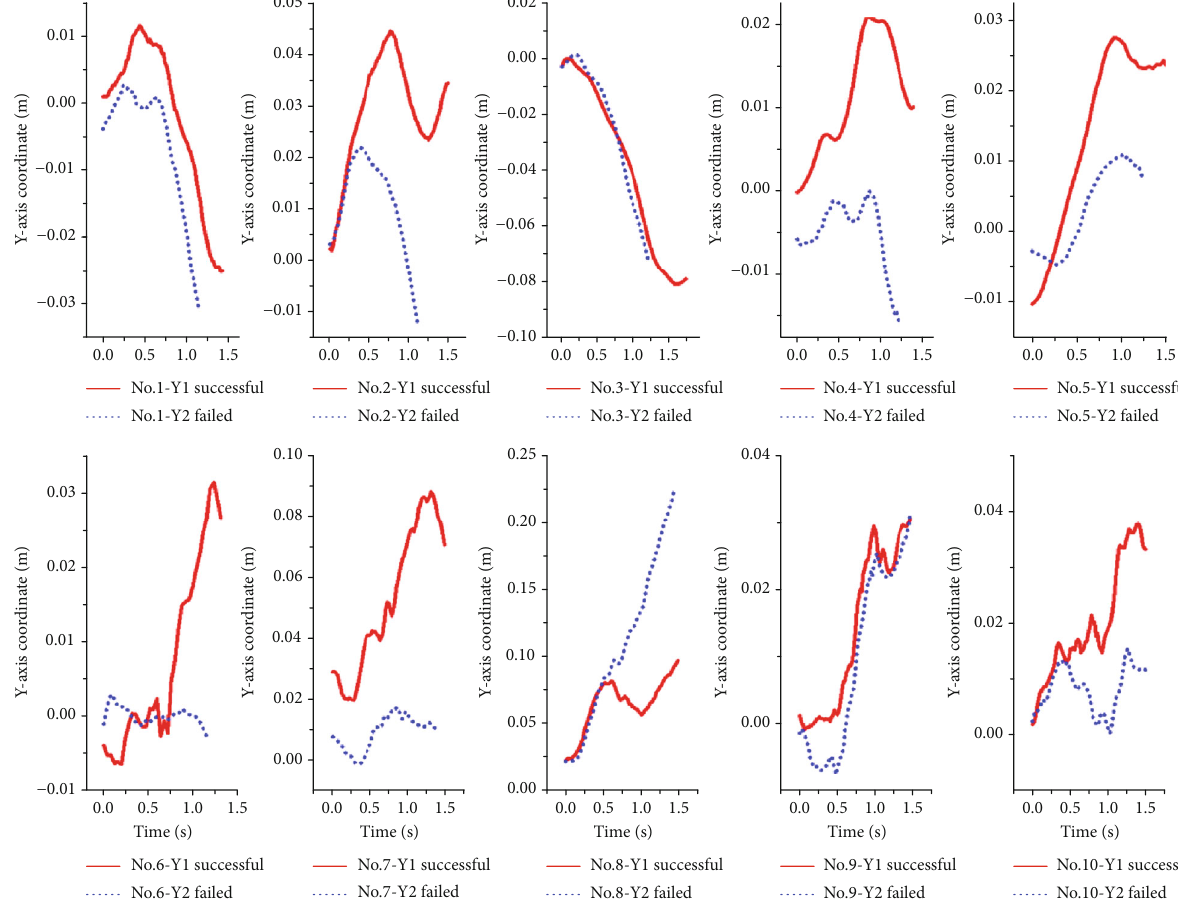
Figure 5: The trajectories of the human and bar combination barycenter of successful and unsuccessful snatch on the Y -